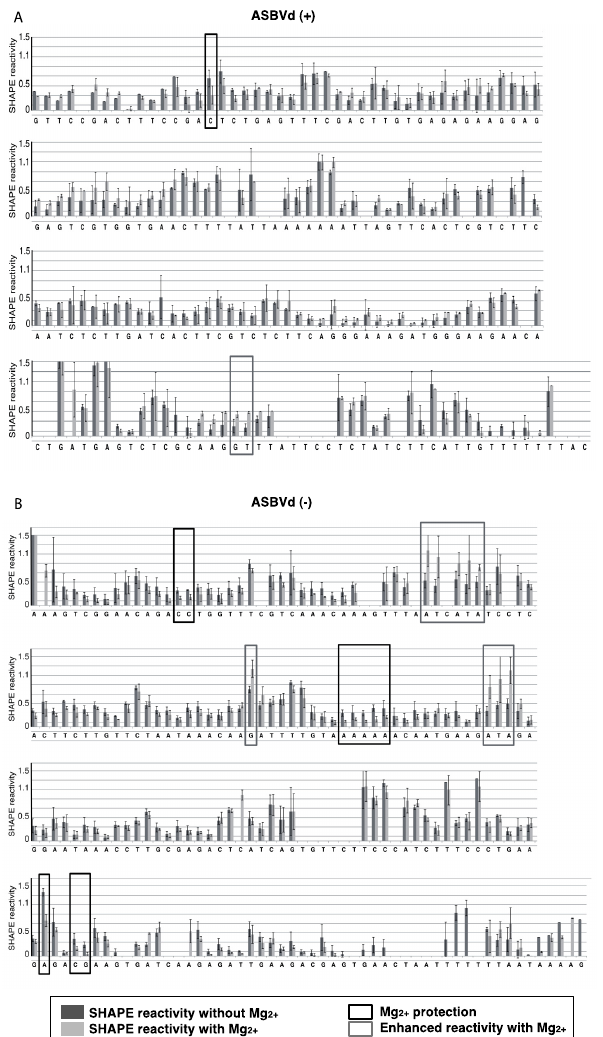
Appendix Figure A1. Comparison of the 1M7 reactivity profiles of ASBVd (+) ( A ) and ASBVd ( − ) ( B ) RNAs in the absence and in the presence of Mg 2+ . The reactivity of each nucleotide is represented in dark grey for the experiment without Mg 2+ and in light grey